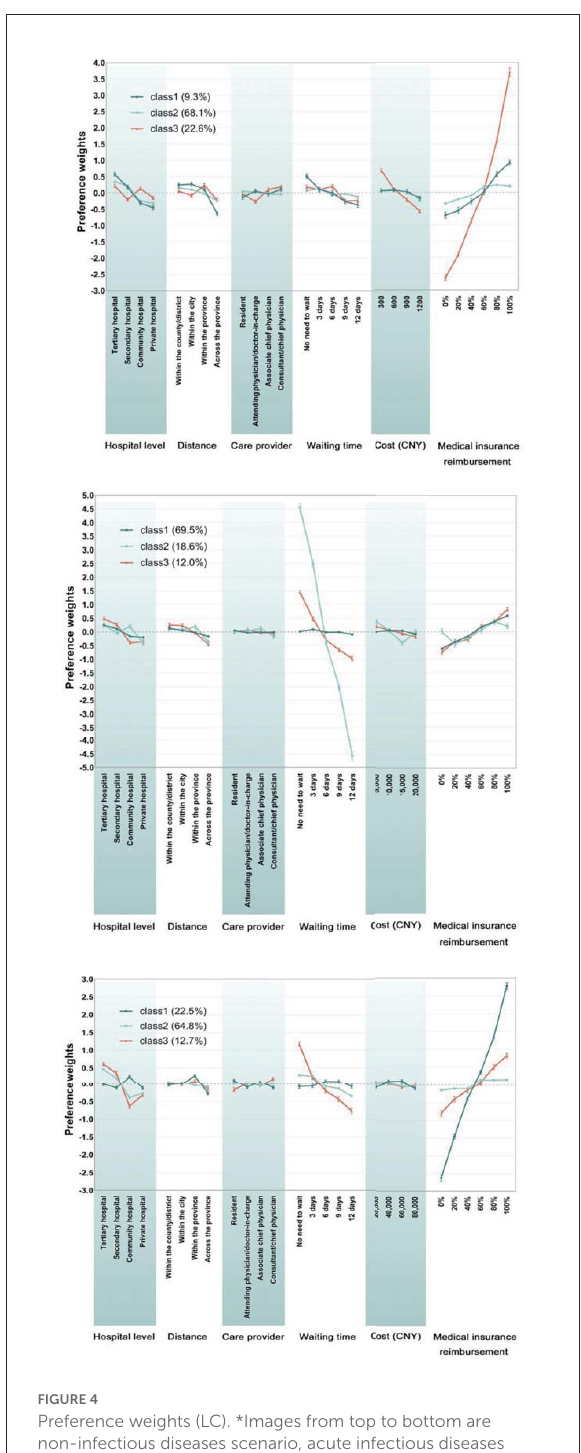
FIGURE4 Preference weights (LC). *Images from top to bottom are non-infectious diseases scenario, acute infectious diseases scenario and major diseases